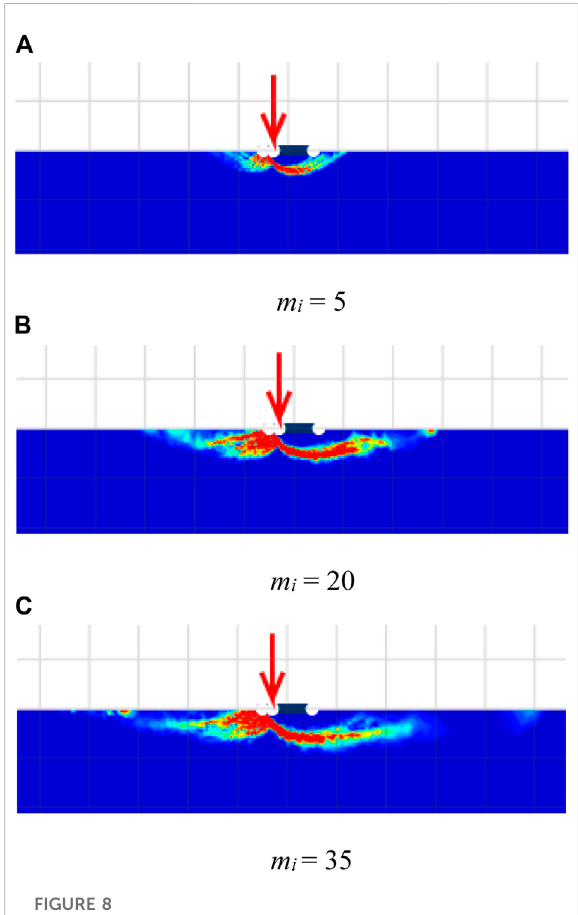
FIGURE 8 Sheardissipationsforvarious m i with β =90 ° , GSI =100, α =1, γ B/ σ ci = 0, and e/B = 0.3. (A) m i = 5 (B) m i = 20 (C) m i =